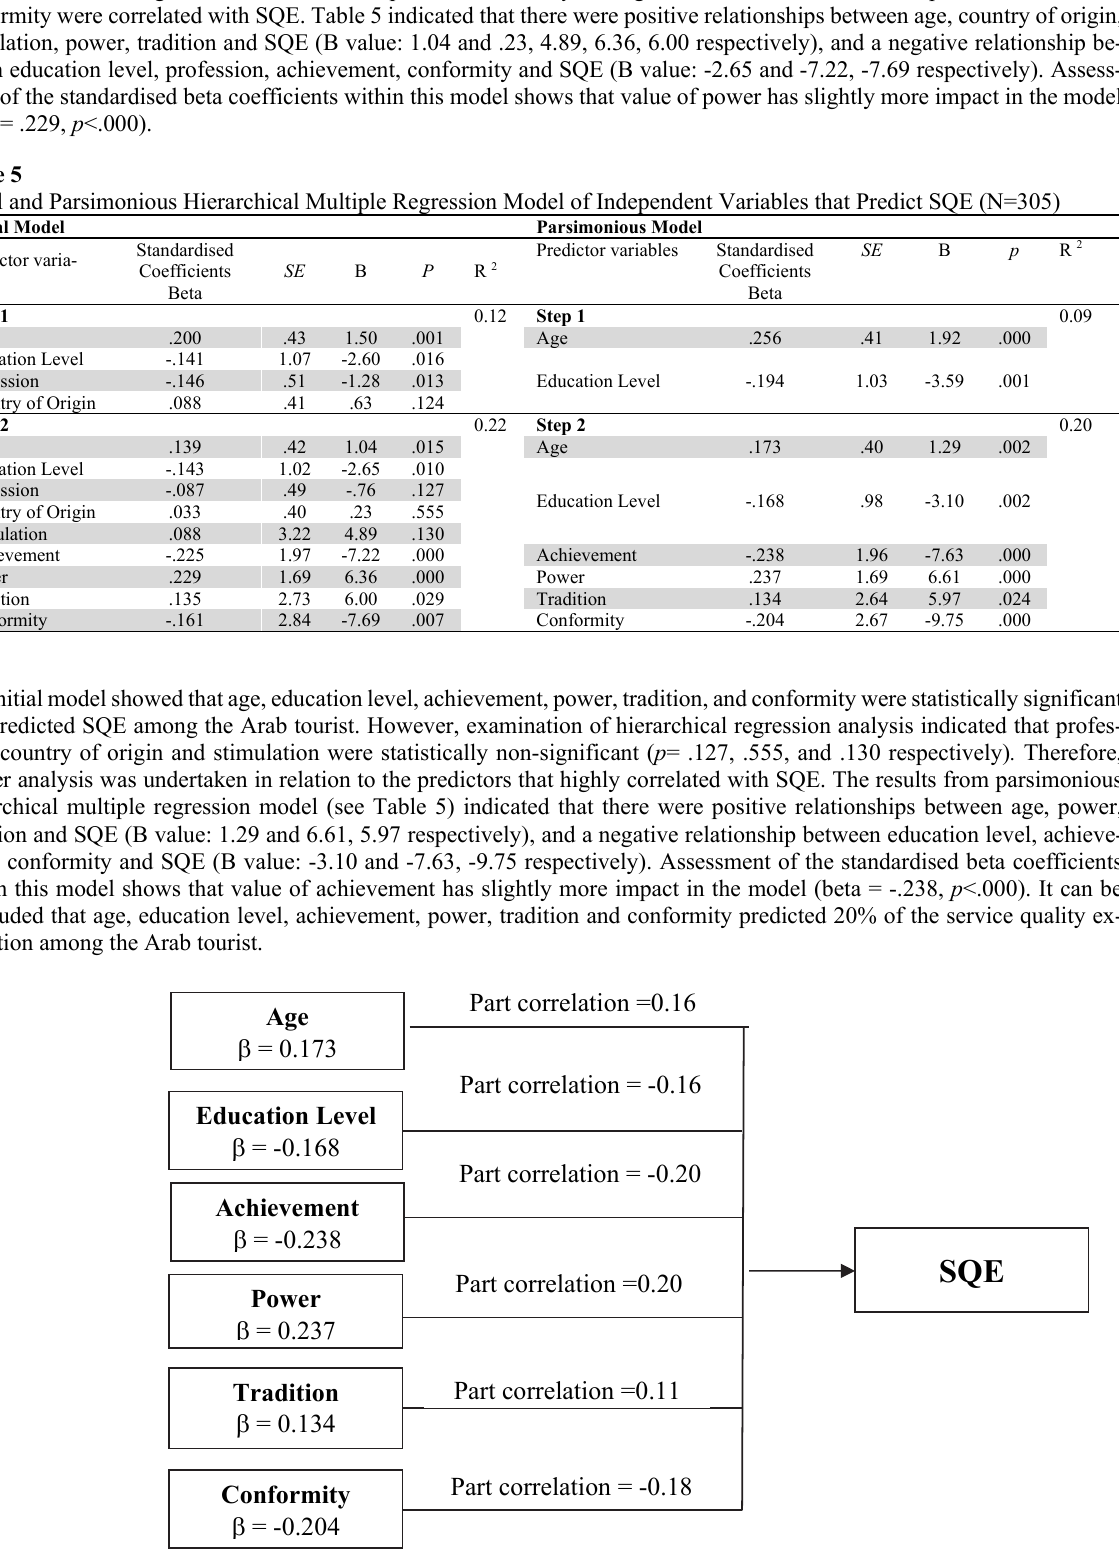
Fig. 2. Summarises the Multivariate Results between Independent Variables and